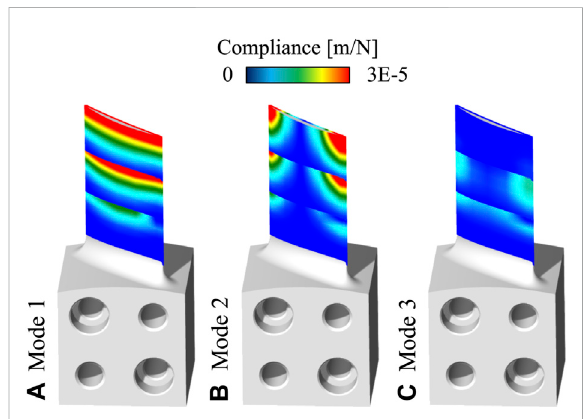
FIGURE 8 Interpolation on f z -steps of the magnitudes for mode shapes 1 to 3 of block 1 to 3. (A) Mode 1, (B) Mode 2, (C) Mode 3.